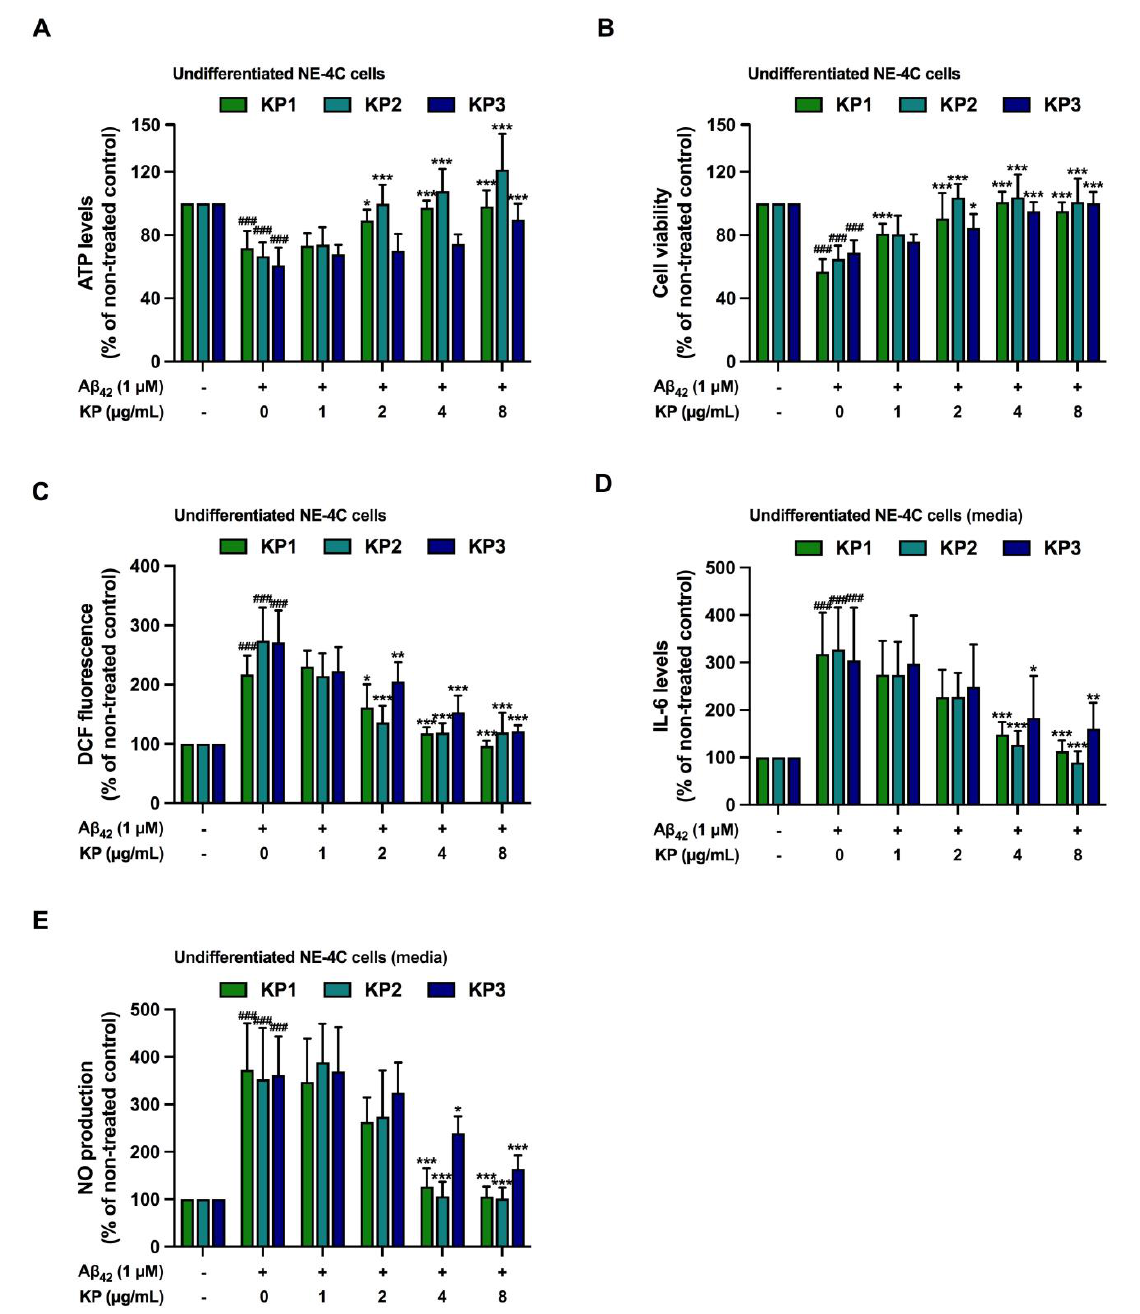
Figure 6. Anti-inflammatory and antioxidant effects of five K. parviflora fractions on Aβ 42 -induced neurotoxicity in co-culture between undifferentiated NE-4C and BV-2 cells. ( A ) ATP levels of undifferentiated NE-4C, ( B ) cell viability of undifferentiated NE-4C, ( C ) DCF fluorescence of undifferentiated NE-4C, ( D ) IL-6 levels in culture media, and ( E ) NO production in the culture media. Values are mean ± SD of three independent experiments. The ### shows a significant difference between the control and cells exposed to Aβ 42 peptides without KP extract at p < 0.001 using one-way ANOVA followed by Tukey’s test. The * shows a significant difference between cells exposed to Aβ 42 peptides without KP extract compared to cells exposed to Aβ 42 peptides and various concentrations of KP extract (1–8 µ g/mL) using one-way ANOVA followed by Tukey’s test. *, p < 0.05, **, p < 0.01, ***, p <